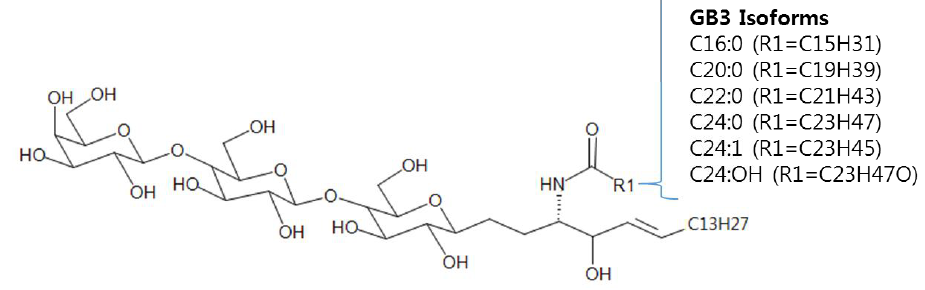
Figure 1. Structure of Globotriaosylceramide (GB3).